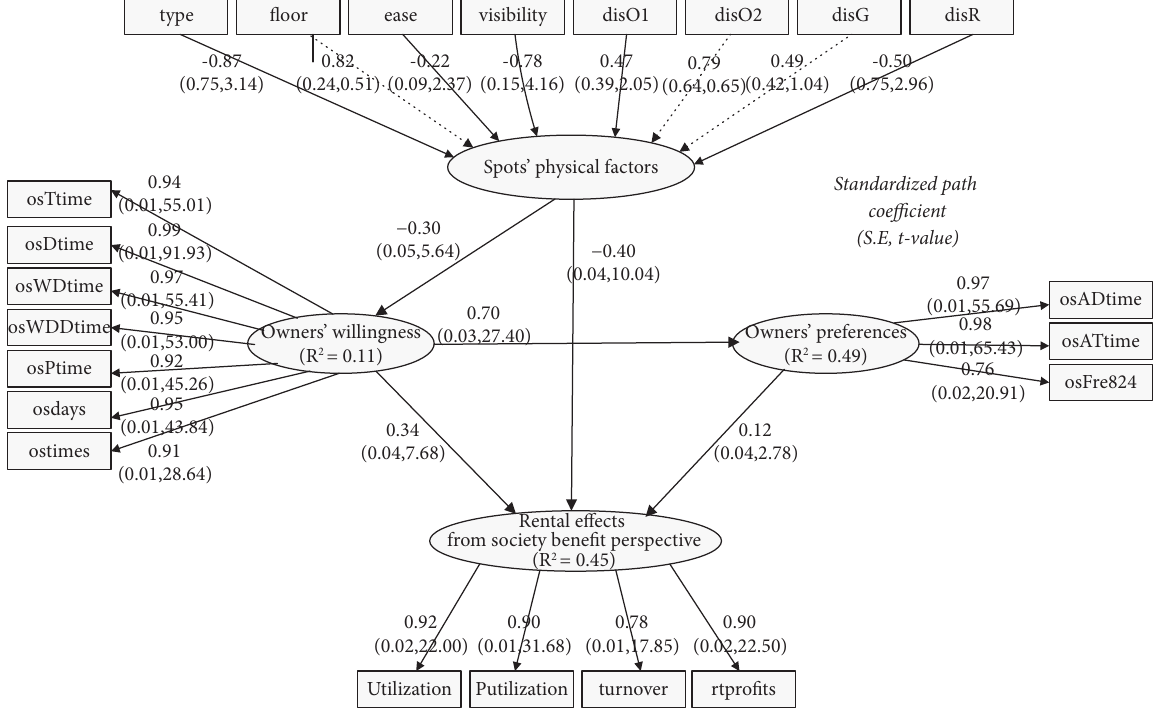
Figure 6: Model structure from a society benefit perspective. Table 3: Effects of latent variables in society model.